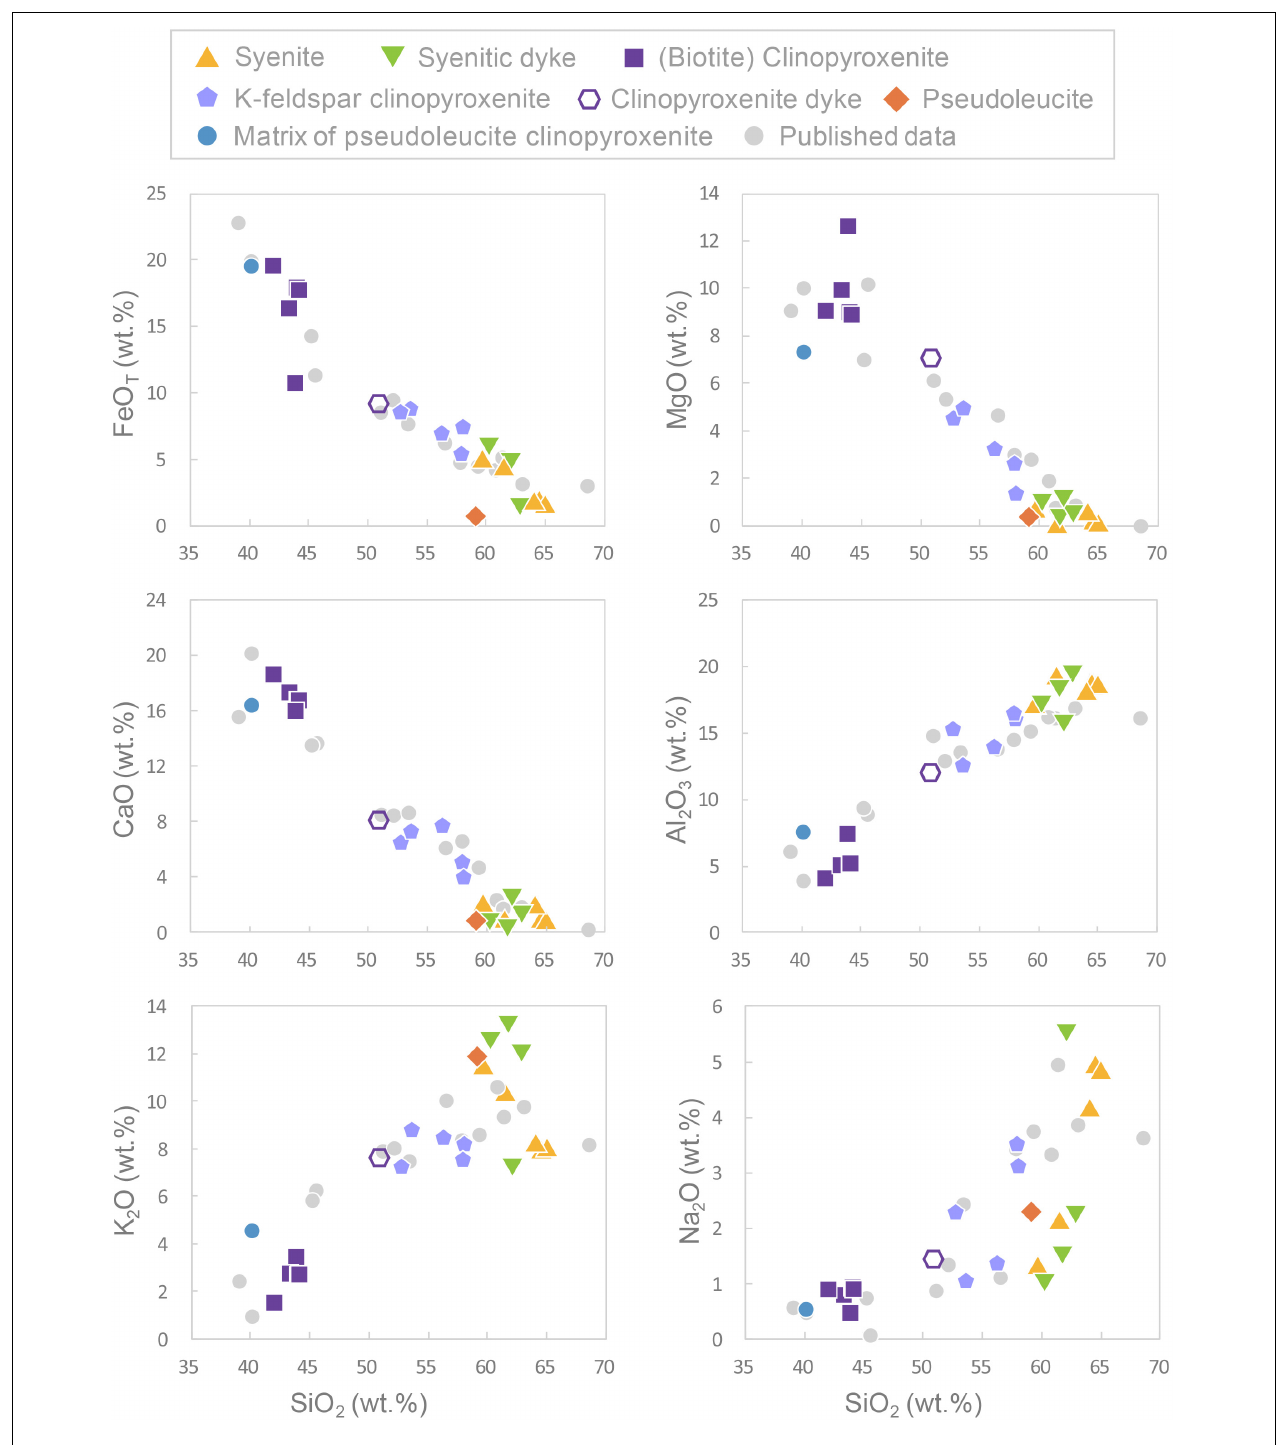
FIGURE 9 | Harker diagrams of the syenite, (biotite) clinopyroxenite, K-feldspar clinopyroxenite, pseudoleucite and matrix of the pseudoleucite clinopyroxenite rocks, and dykes. Published data of Yaojiazhuang complex are from Mu and Yan (1992) and Chen et al. (2013).